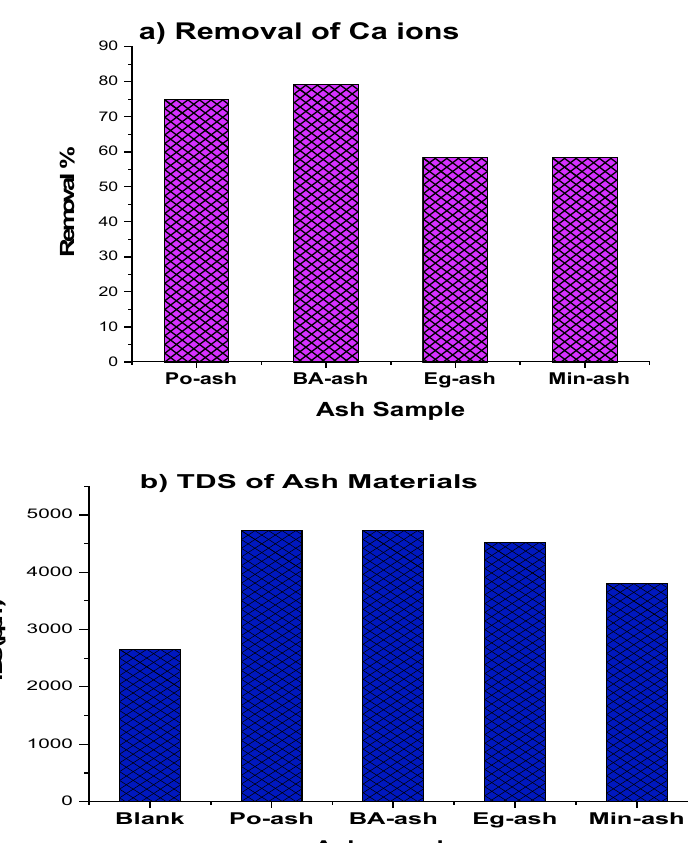
Figure 5. Comparison of the examined ash samples: ( a ) %Ca removal; ( b ) TDS in solution. Table 5. Quality changes in 100 mL of distilled water by adding 1 g of the tested